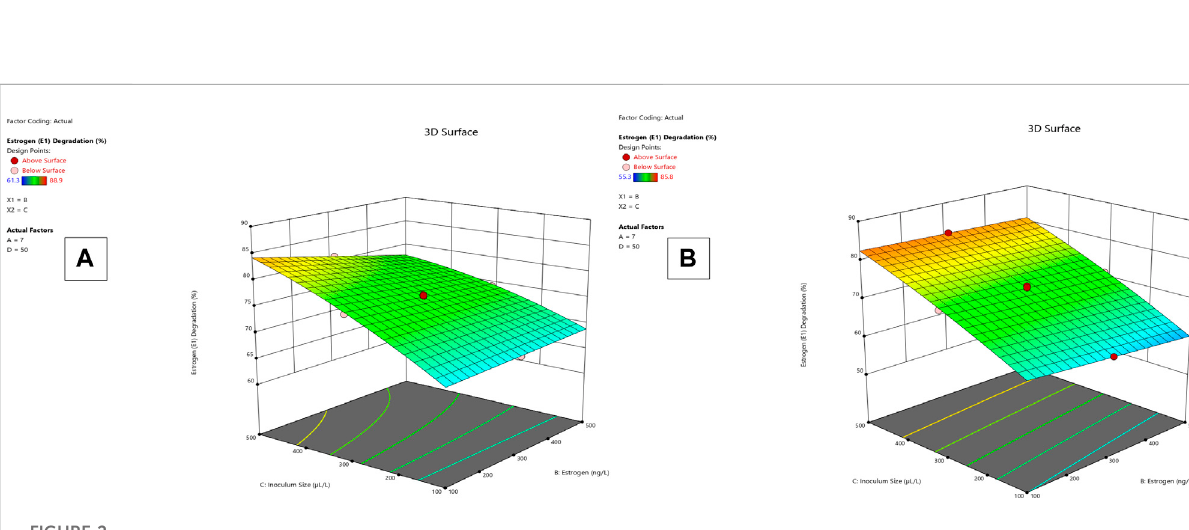
FIGURE 2 E1 degradation 3D mesh diagram for Lysinibacillus. BP1 (A) and Lysinibacillus. BP2 (B)